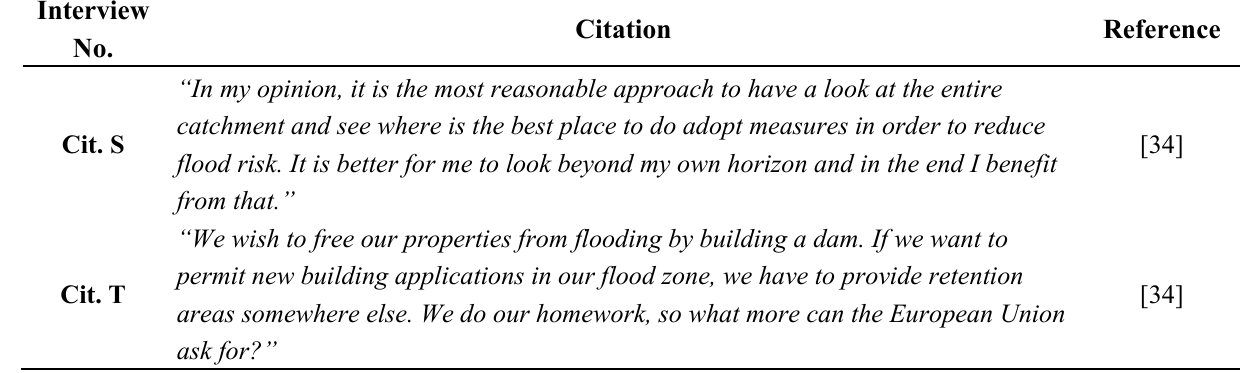
Table 7. Citations representing municipalities with different opinions on FRM